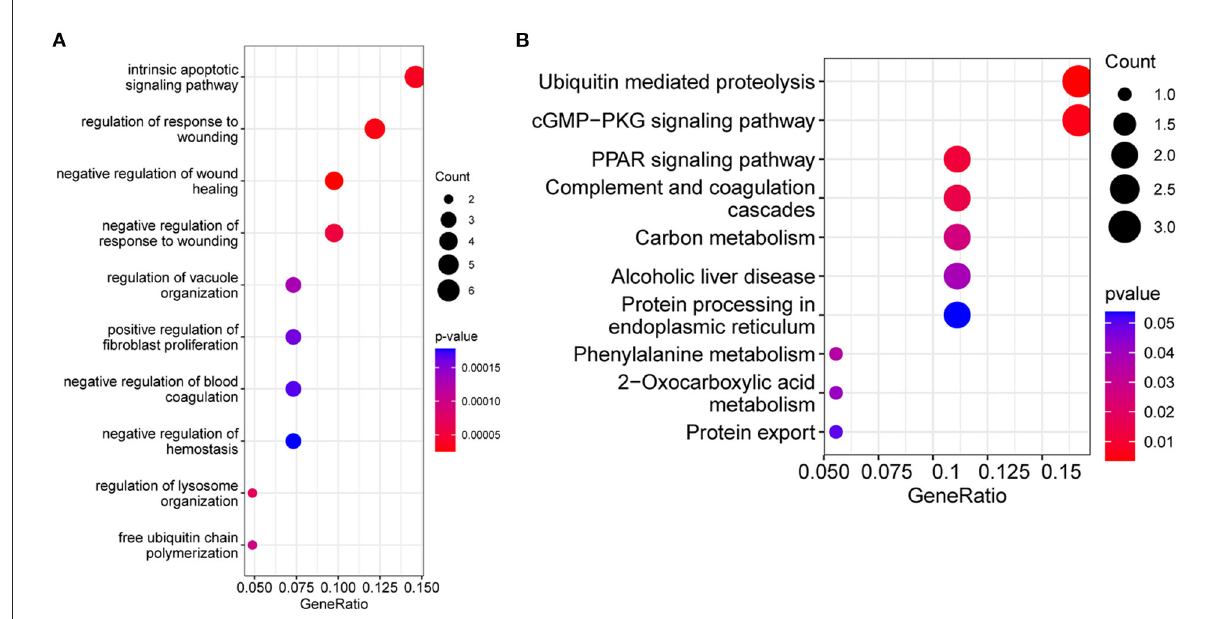
FIGURE4 Functional enrichment analysis results of the intersecting genes between the MEskyblue module and the DEGs. (A) Bubble diagram of the top 10 GO terms. (B) The top 10 KEGG pathways. The size of bubbles indicates number of enrichment genes, and the color indicates